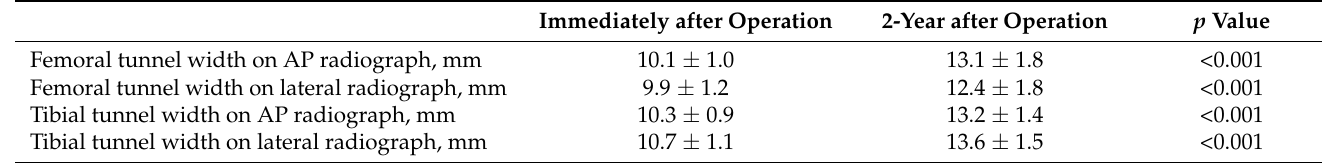
Table 3. Tunnel widths on anteroposterior and lateral knee radiographs at immediate and 2-year post-operation. Immediately after Operation 2-Year after Operation p